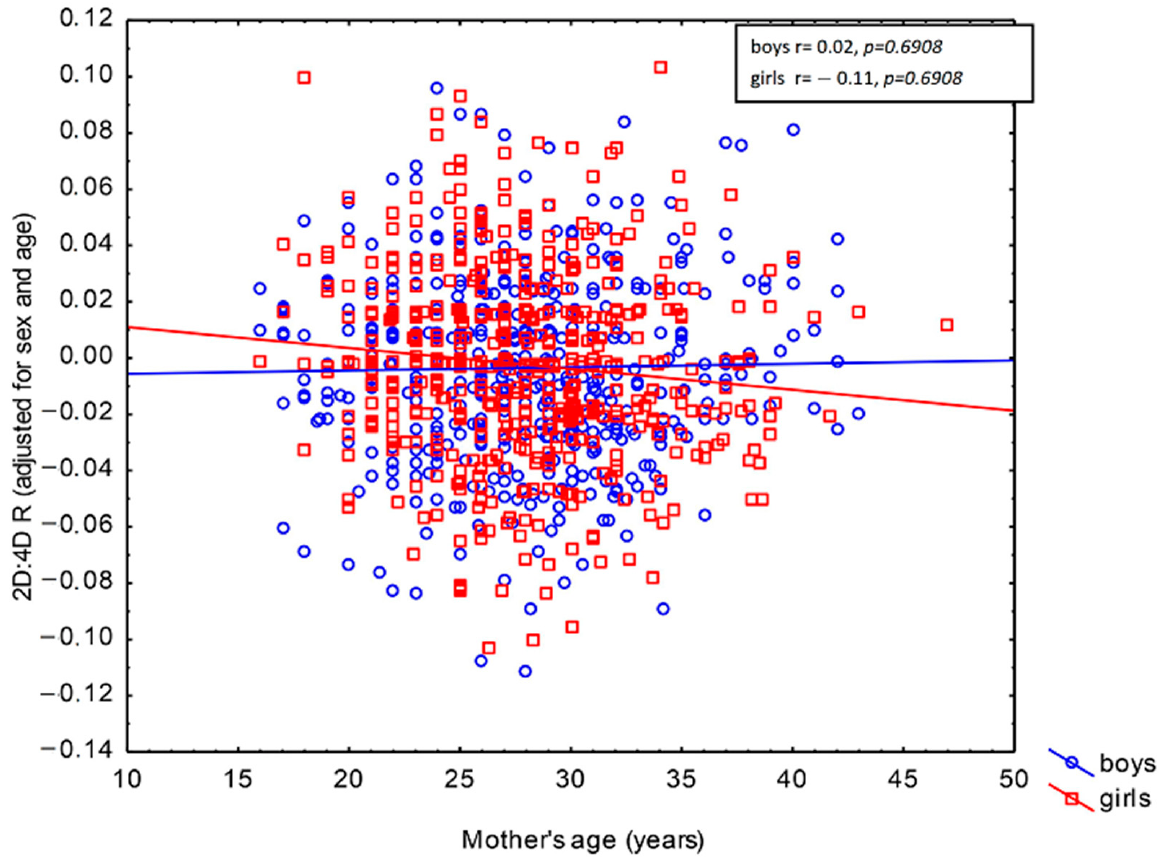
Figure 1. Correlation between maternal age at childbirth and the right 2D:4D digit ratio in children aged 6–13 years depending on sex. Table 5. Correlations between maternal prenatal factors and the left hand 2D:4D digit ratio 1 in children aged 6–13 years (GLM).